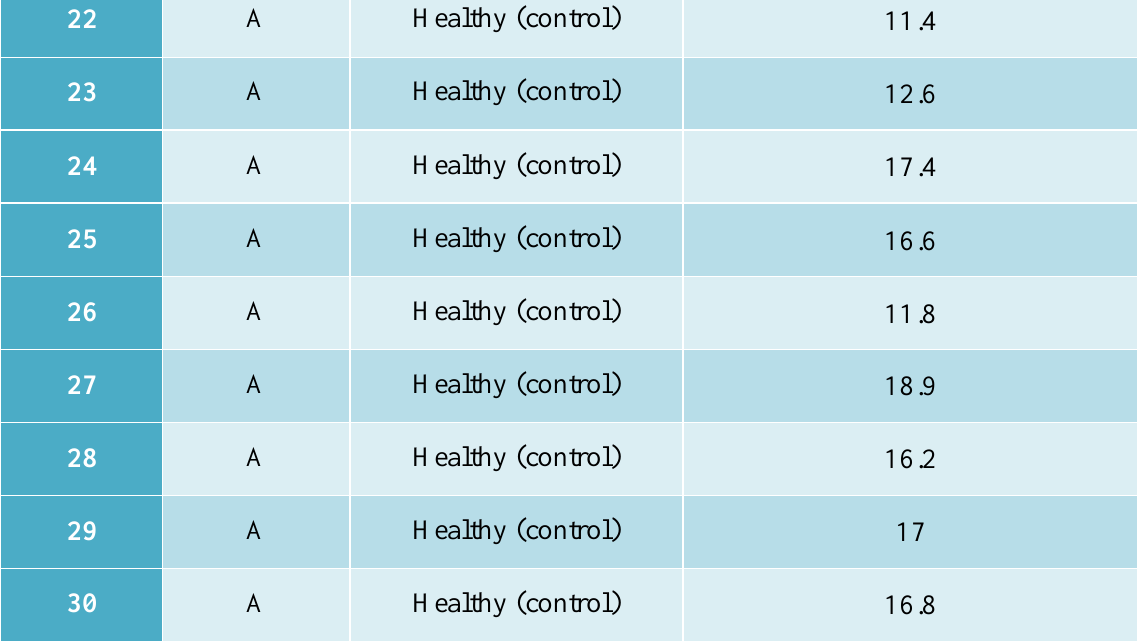
Table3: The results of the Concentration of Interferon gamma (IFNγ) in serum of cancer